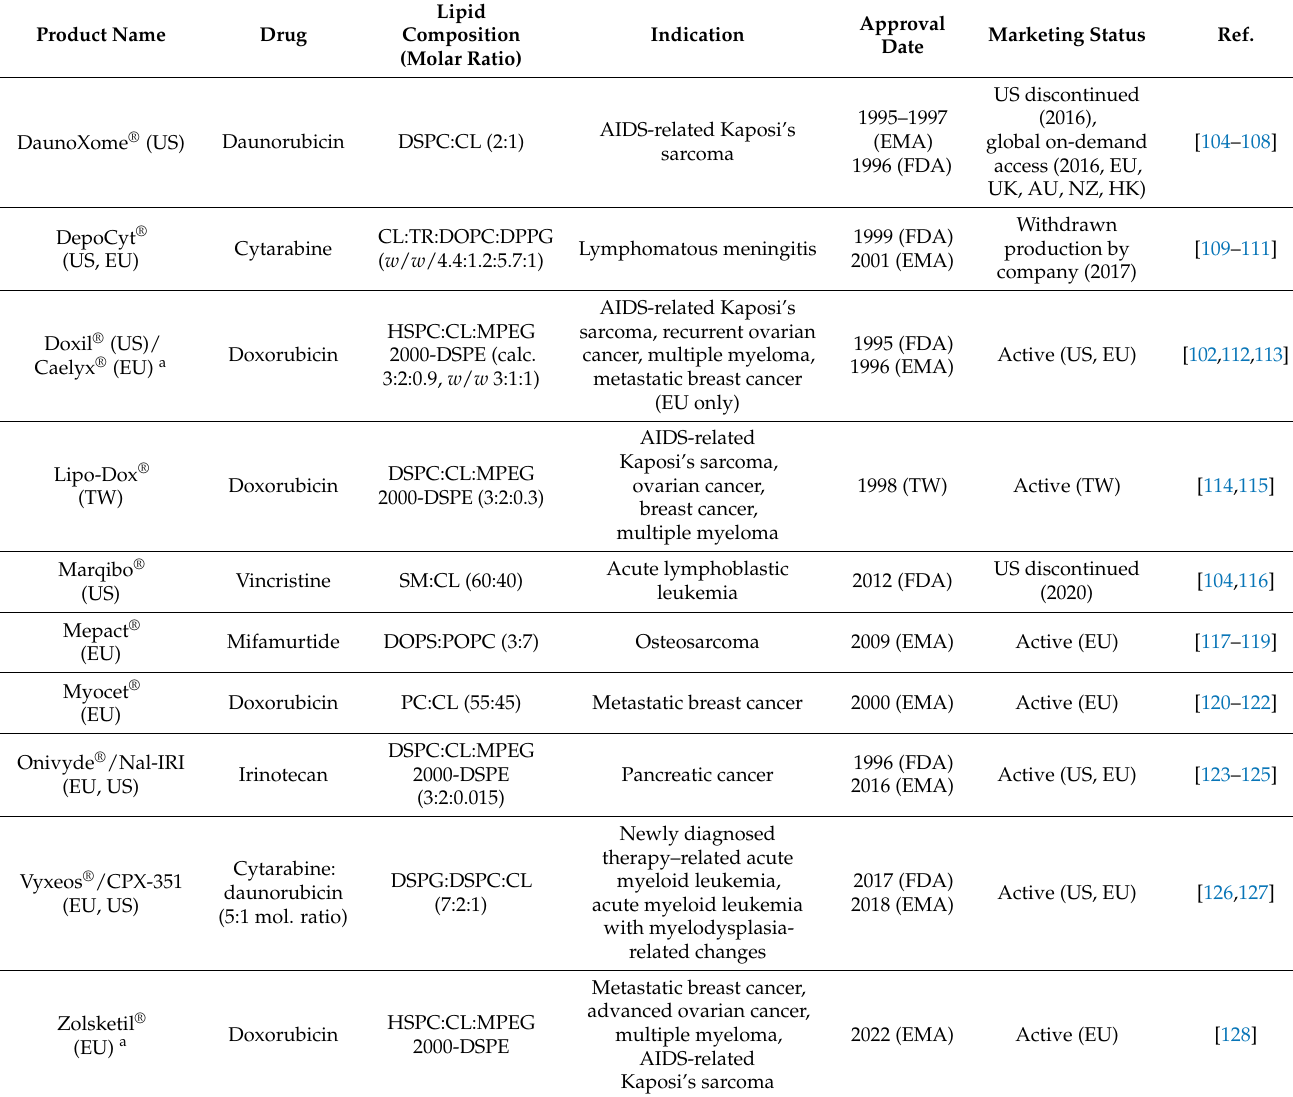
Table 1. Approval and Marketing History of Liposomal